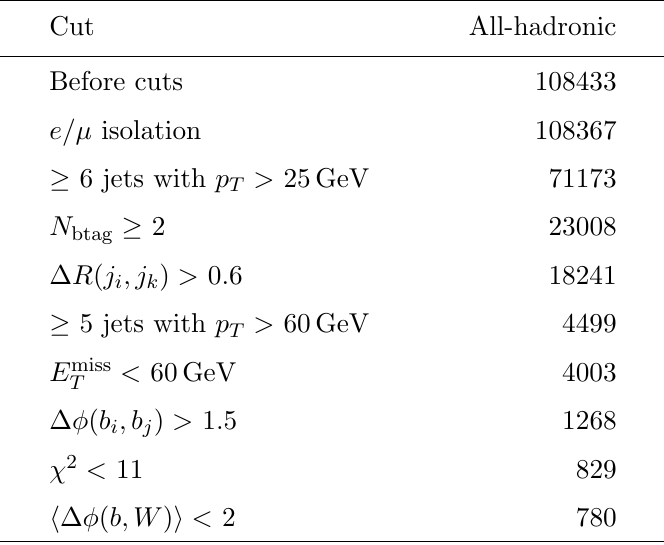
Table 2 . The cut-(cid:13)ow table for all-hadronic sample with m t = 172.5 GeV. The initial number of events is determined using the ATLAS integrated luminosity L = 20 : 2 fb (cid:0) 1 and the production cross section as calculated using MadGraph5 aMC@NLO